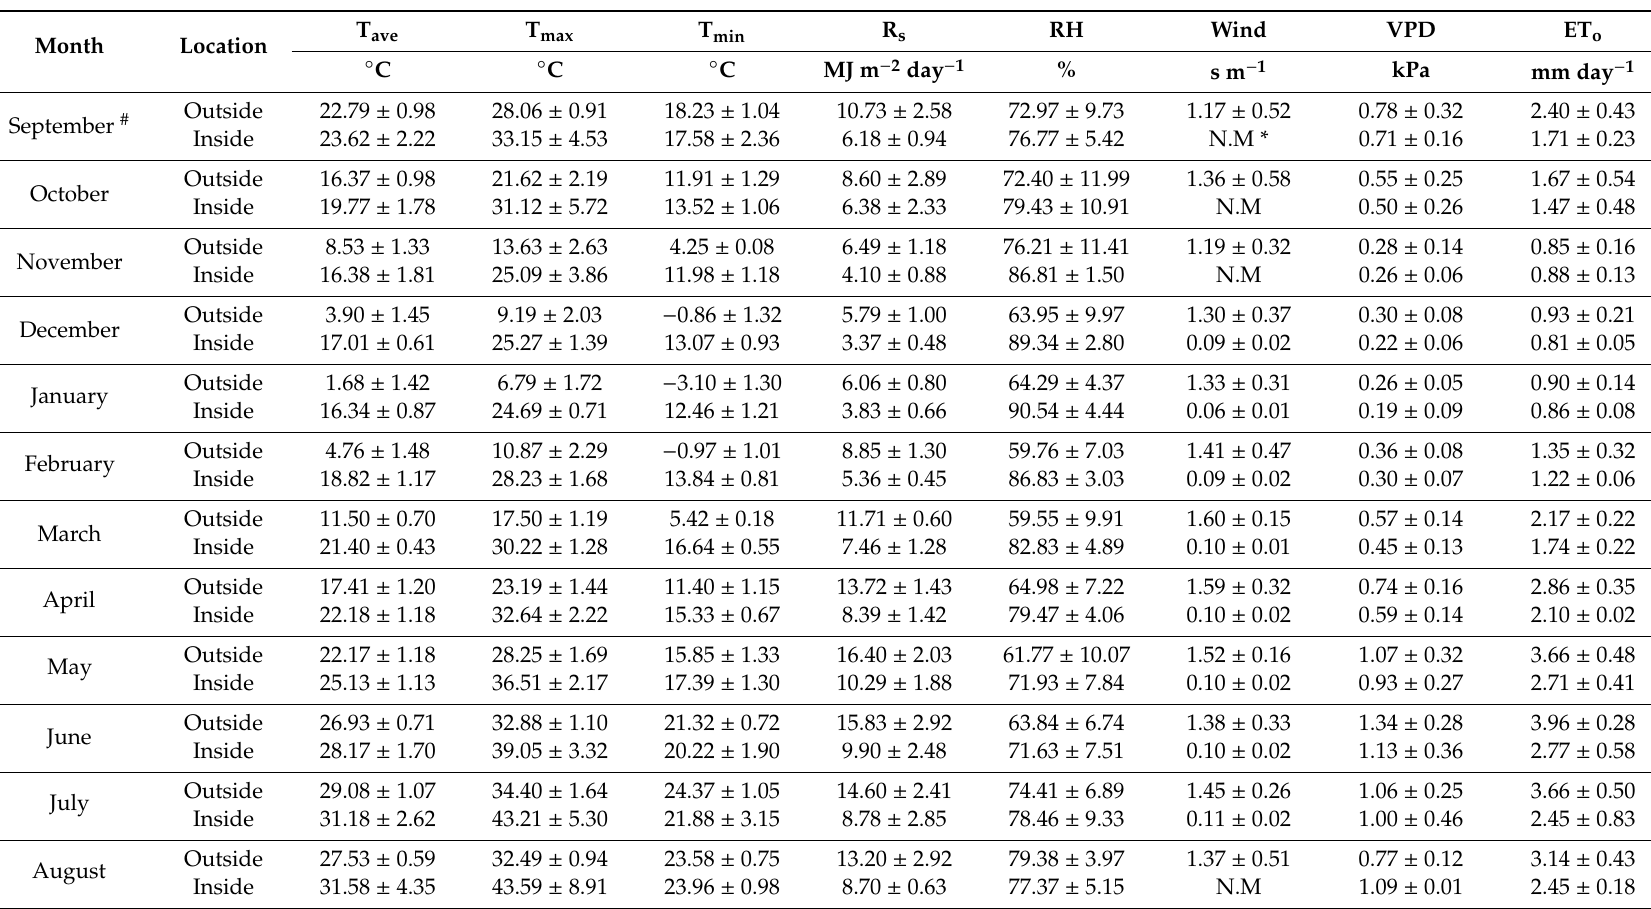
Table 4. Summary of the monthly mean climate condition, mean (T ave ), maximum (T max ) and minimum (T min ) daily temperatures, daily solar radiation (R s ), relative humidity (RH), vapor pressure deficit (VPD), wind speed, and reference crop evapotranspiration (ET o ) inside and outside the